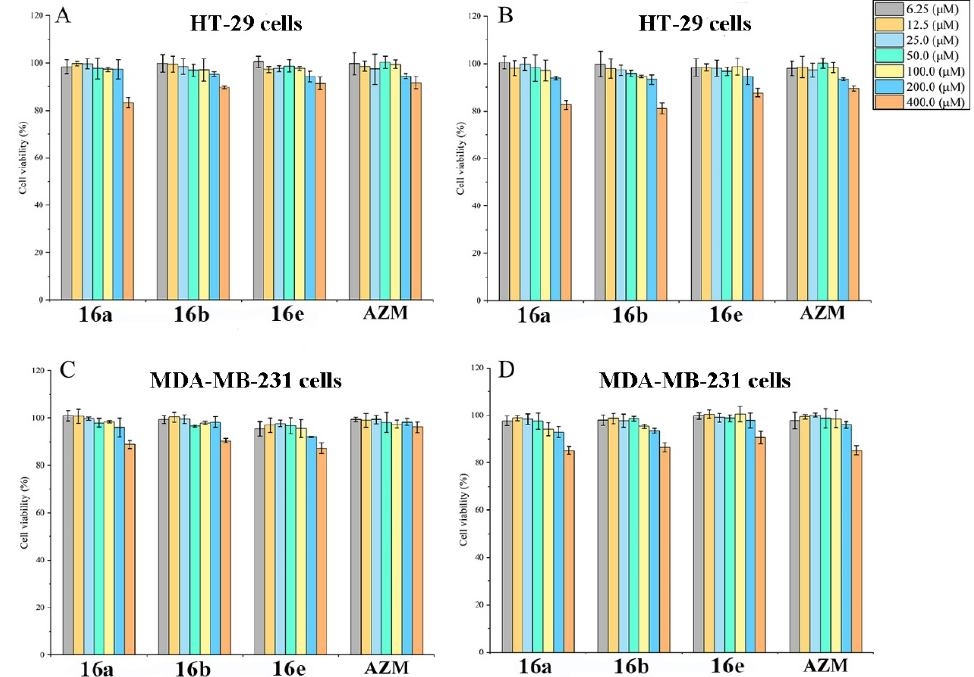
Figure 2. Effects of compounds 16a , 16b , 16e , and AZM on the cell viability of HT-29 and MDA-MB- 231 cells under normoxic ( A , C ) and hypoxic ( B , D ) conditions.